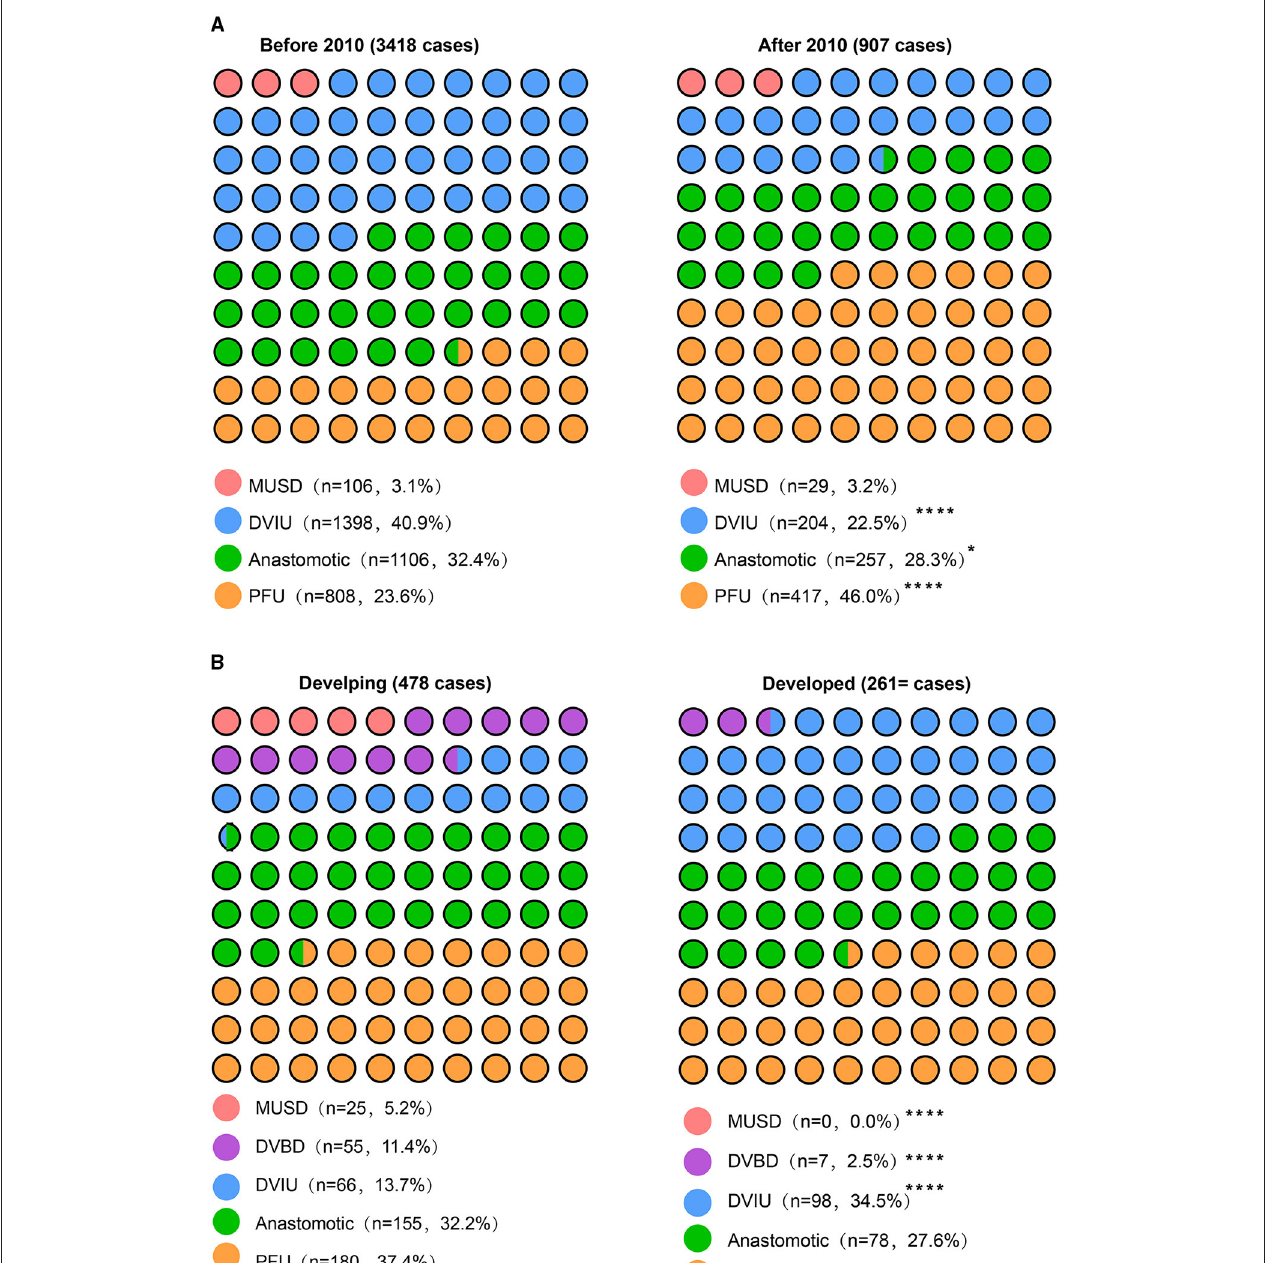
FIGURE 2 | Treatment options between the two groups. (A) The patients were grouped by treatment time; (B) the patients were grouped by developing and developed regions. * = p < 0.05; ** = p < 0.01; *** = p < 0.001; **** = p <